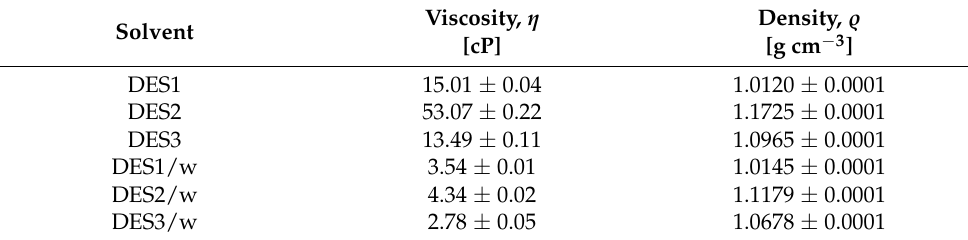
Table 1. Viscosities and densities of DESs and their 70/30 w / w water mixtures at 60 ◦ C. Viscosity, η Density, (cid:36) Solvent [cP] [g cm − 3 ] DES1 15.01 ± 0.04 1.0120 ± 0.0001 DES2 53.07 ± 0.22 1.1725 ± 0.0001 DES3 13.49 ± 0.11 1.0965 ± 0.0001 DES1/w 3.54 ± 0.01 1.0145 ± 0.0001 DES2/w 4.34 ± 0.02 1.1179 ± 0.0001 DES3/w 2.78 ± 0.05 1.0678 ±